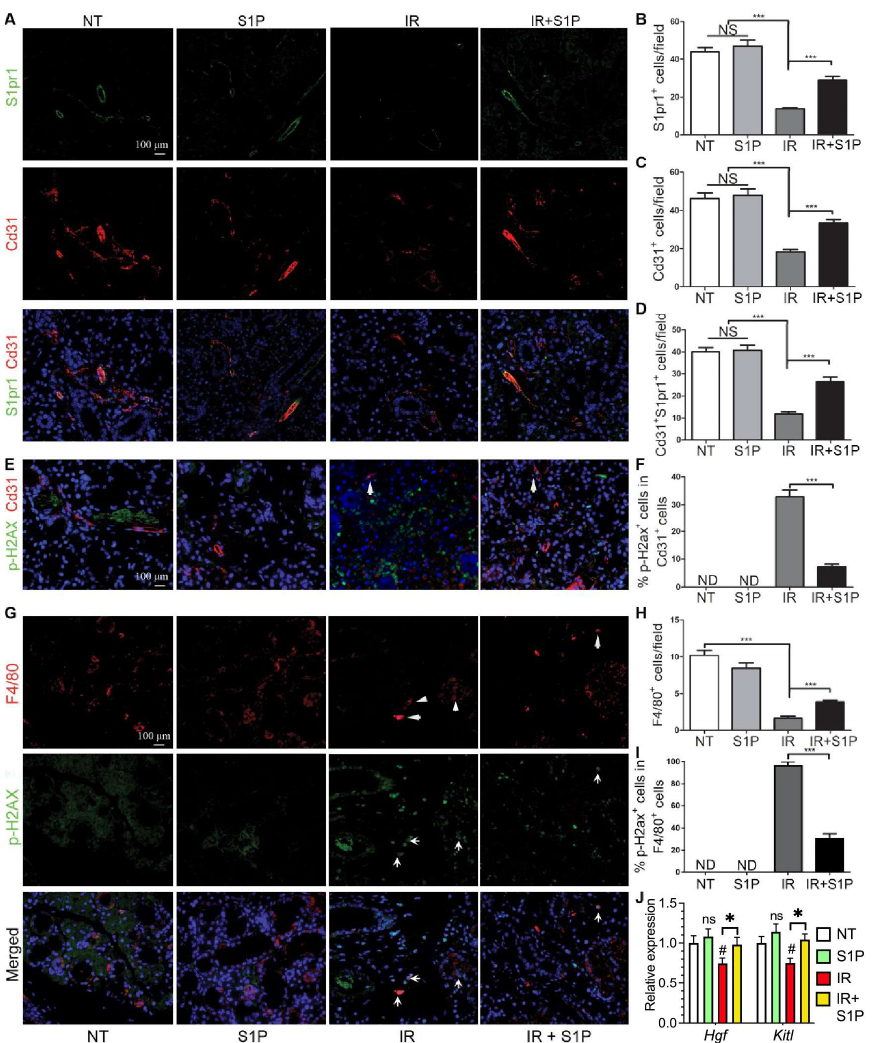
Figure 5. Effects of S1P on endothelial cells and macrophages in radiated salivary glands. ( A – D ) Expression of S1pr1 and Cd31 in SMGs collected at 7 days after IR were examined with double immunofluorescence staining and quantified. ( E , F ) Levels of p-H2ax in Cd31 + endothelial cells in SMGs collected at 7 days after IR were examined with double immunofluorescence staining and quantified. ( G – I ) Expression of F4/80 and levels of p-H2ax in F4/80 + macrophages in SMGs collected at 7 days after IR were examined with double immunofluorescence staining and quantified. ( J ) mRNA levels of macrophage-enriched Hgf and endothelia-enriched Kitl in SMGs collected at 7 days after IR were examined with RT-qPCR. Quantified data are shown as mean ± SD, N = 3, NS: not significant vs. NT, ND: not detected, # : p < 0.05 vs. NT, *: p < 0.05, ***: p < 0.001. Quantitative data were analyzed using one-way ANOVA with Tukey’s multiple comparisons.